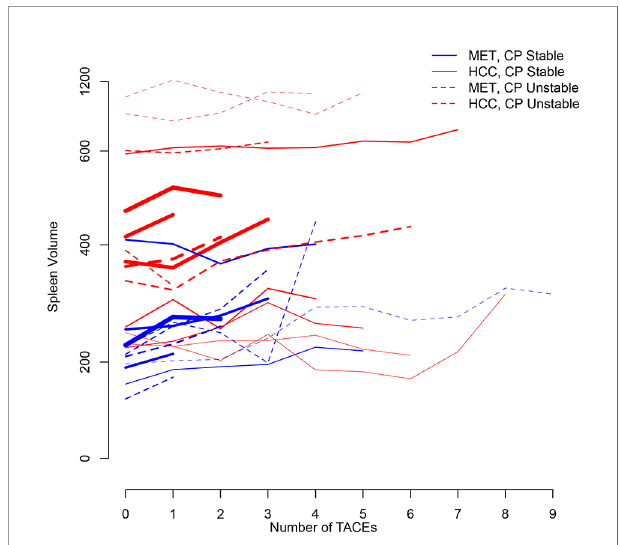
FIGURE 2 | Trajectory plot illustrating longitudinal changes over time in spleen volume according to the number of TACEs and strati fi ed by Child- Pugh (CP) stability (line = stable, dotted line = unstable) and metastatic (MET)/ HCC groups, respectively. Line thickness is proportional to patient number (the thicker the line the more